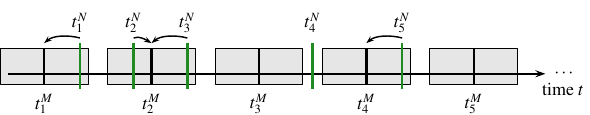
Figure 3. Temporal co-location of MACC (model, black) and NORS (measurement, green)